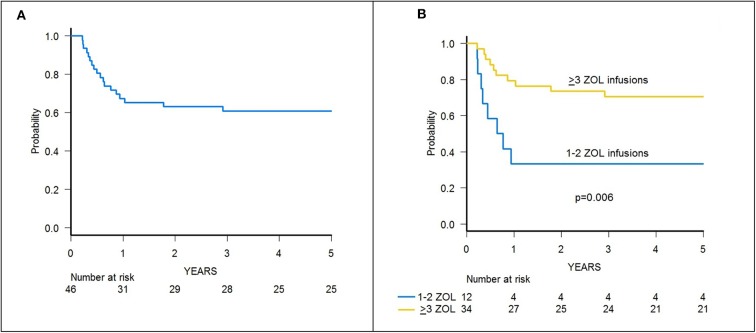
(A) GRFS of the whole cohort of 46 patients. (B) GRFS of patients receiving either 1–2 or ≥3 infusions of zoledronic acid (ZOL).